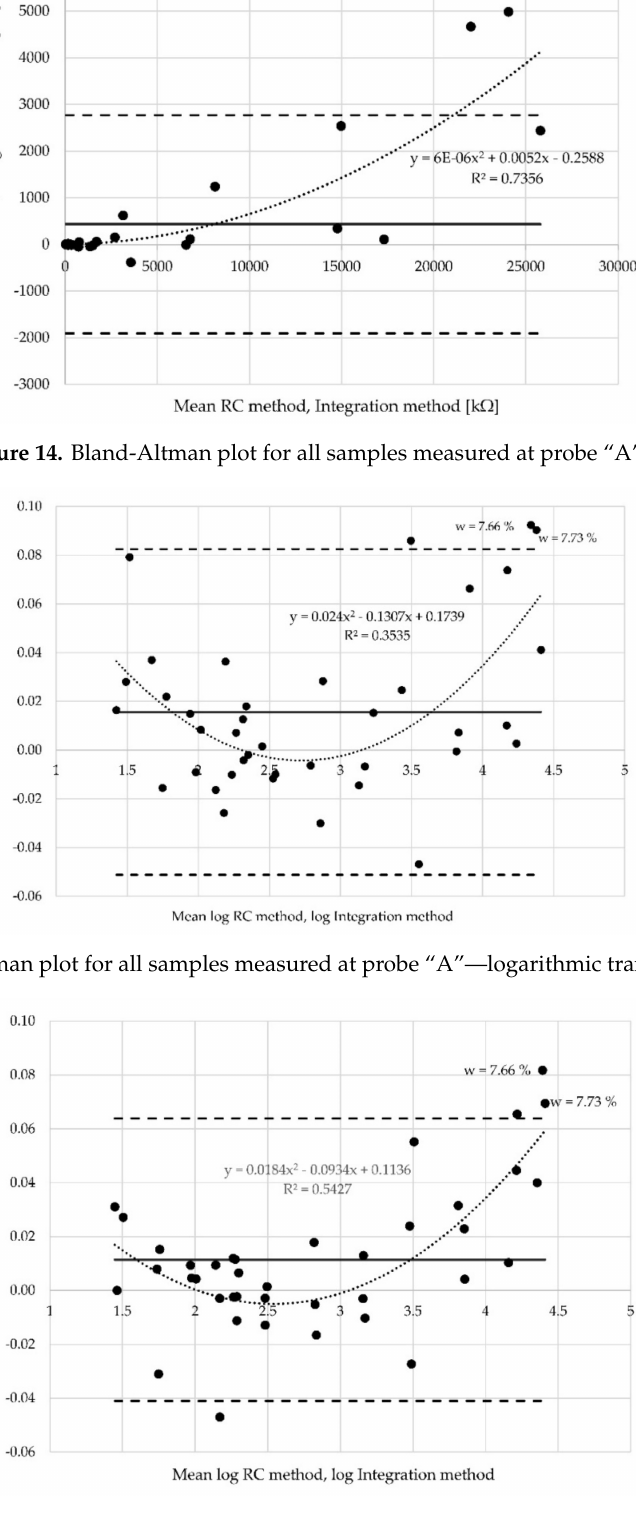
Figure 16. Altman plot for all samples measured at probe “B”—logarithmic